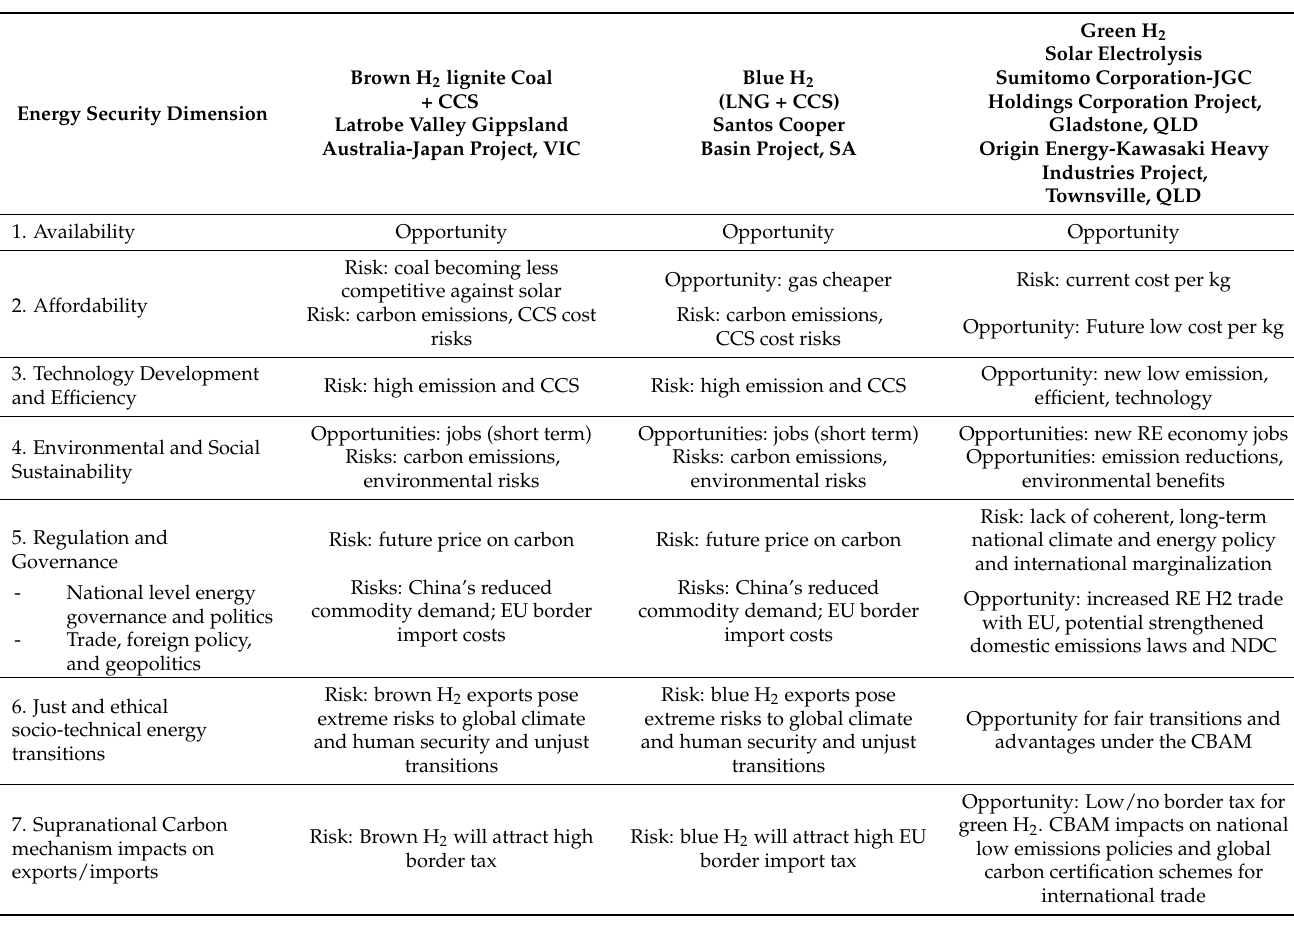
Table 2. Risk and opportunity analysis across applied seven-dimension energy security-justice framework: Australian projects.